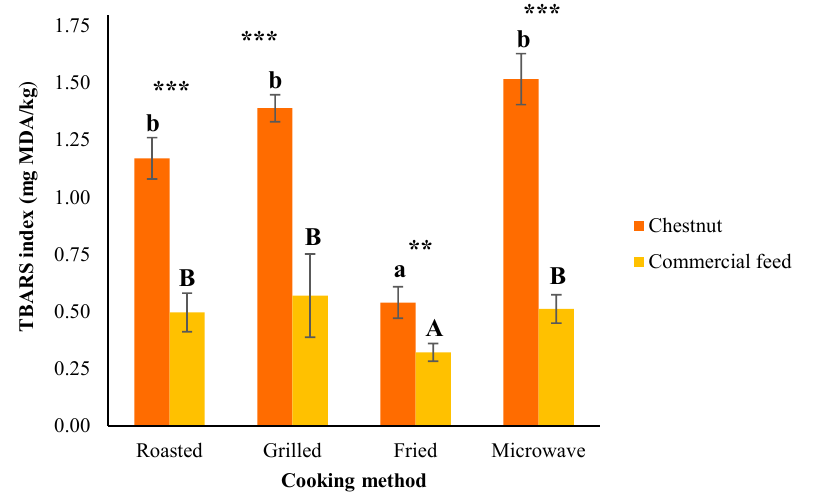
Figure 1. Effects of the inclusion of chestnut in the finishing diet and of cooking methods on the thiobarbituric acid reactive substances (TBARS) index of Celta pig Biceps femoris (mean ± standard error). Influenced by feeding: * ( P < 0.05); ** ( P < 0.01); *** ( P < 0.001); ns: no significant difference. Different letters within the same feeding regimen (chestnut ( a,b ) or commercial feed ( A,B )) indicate significant differences for cooking methods ( P < 0.05).